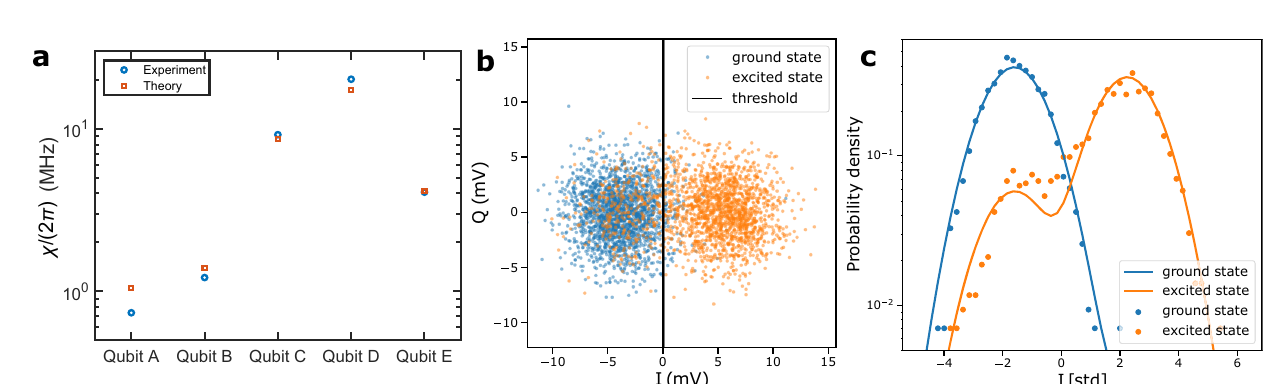
Fig. 7 | Dispersive shift and single-shot qubit readout. a Measured dispersive shift χ for different unimon qubits at a fl ux bias of Φ diff = Φ 0 /2 (blue circles) toge- ther with theoretical predictions (orange squares) computed using Eq. (8) in “ Methods ” based on the measured qubit frequency, measured anharmonicity, and the fi tted coupling capacitance C g , all of which are reported in Table 1. b Readout voltagesinthe IQ planeforasingle-shotreadoutexperimentconductedforqubitE. The qubit is prepared either to the ground state (blue dots) or to the excited state (orange dots) followed by a single-shot state measurement implemented using a readout pulse with a duration of 1.6 μ s. The state preparation was repeated 2000